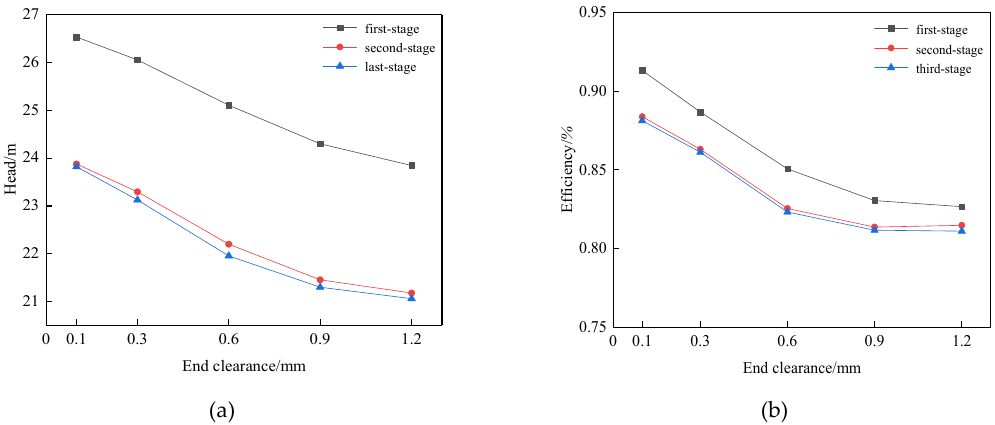
Figure 9. Comparison of impeller head and efficiency at all levels. ( a ) Head of single-stage impeller, ( b ) efficiency of single-stage impeller.